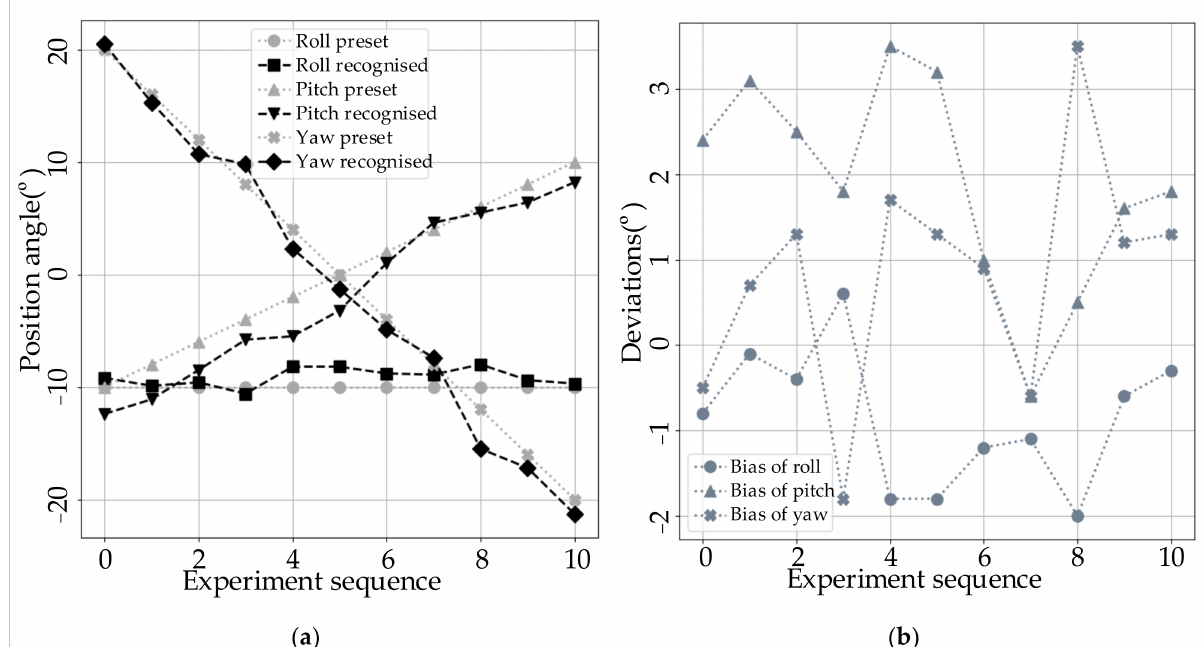
Figure 11. Result of experiment 1: ( a ) experimental result, ( b ) error distribution. The second experimental trajectory is as follows: all three degrees of freedom rotate synchronously in a step of 3 ◦ , in which the pitch angle around the Y axis and the yaw angle around the Z axis decrease from 15 ◦ to − 15 ◦ , and the pitch angle around the Y axis increases from − 15 ◦ to 15 ◦ . The experimental results are shown in Figure 12.